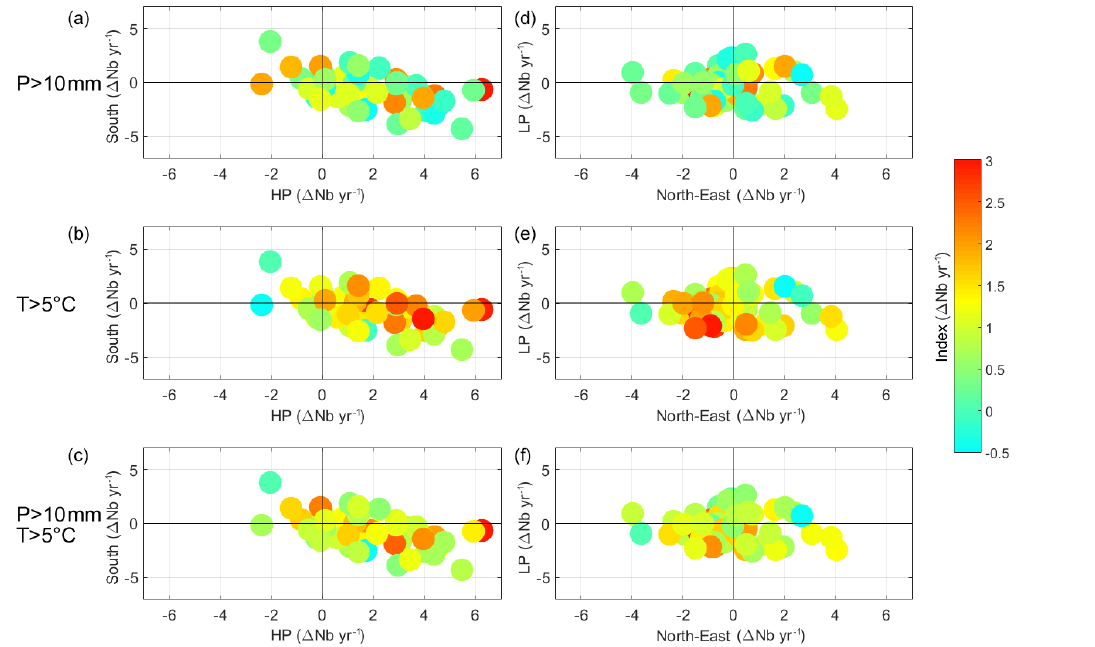
Figure 12. DJF change in occurrences of regimes HP-South (a–c) and LP-North-East (d–f) with respect to the change in number of heavy rain and warm events (colours) for each member of CRCM5-LE between 1961–1990 and